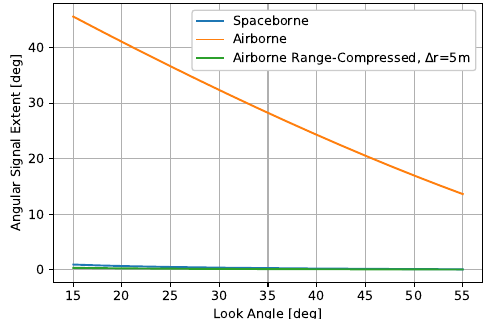
Figure 3. Angular signal extent in elevation for SAR systems operating with a 20 microsecond chirp at H = 3 km (airborne, orange), at H = 600 km (spaceborne. The green line represents the airborne system after range compression.